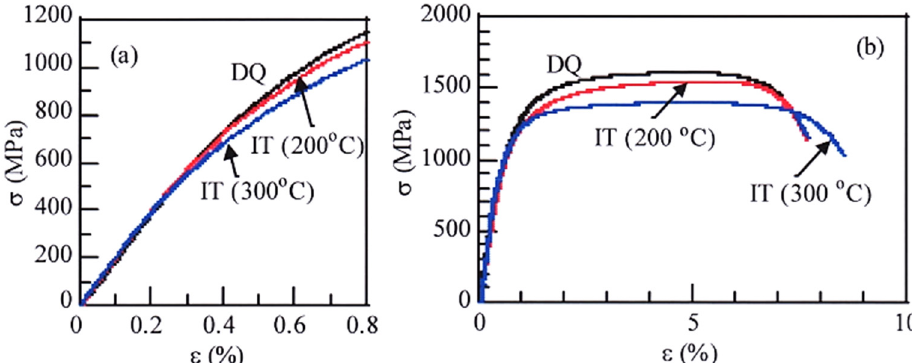
Figure 6. Typical engineering stress − strain ( σ − ε ) curves at room temperature in 0.21%C–1.49%Si–1.50%Mn–1.0%Cr–0.05%Nb TM steel subjected to the DQ process and the IT process at T p = 200 ° C and 300 ° C [63]. ( a ): initial stage, ( b ) overall stage [63]. Measured M s and M f of the steel are 406 ° C and 261 ° C, respectively.